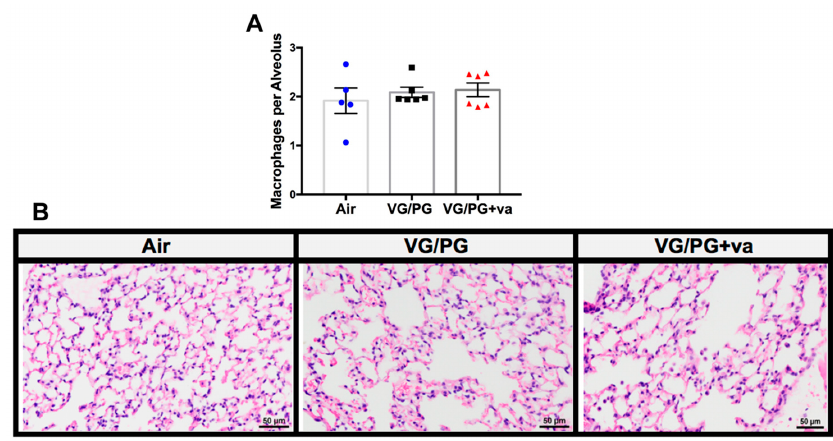
Figure 2. Inhalation of e-cig aerosol composed of 70 / 30% VG / PG alone or with vanilla flavor does not impact lung tissue macrophages. H&E stained lung slides from mice treated with air ( n = 5), VG / PG ( n = 6), and VG / PG plus vanilla ( n = 6) were evaluated for the number of macrophages in 5 representative images at 40x. ( A ) Counts were normalized to the number of alveoli per image to account for di ff erences in lung section inflation. ( B ) Representative images of H&E stained slides of mouse lungs at 400 ×